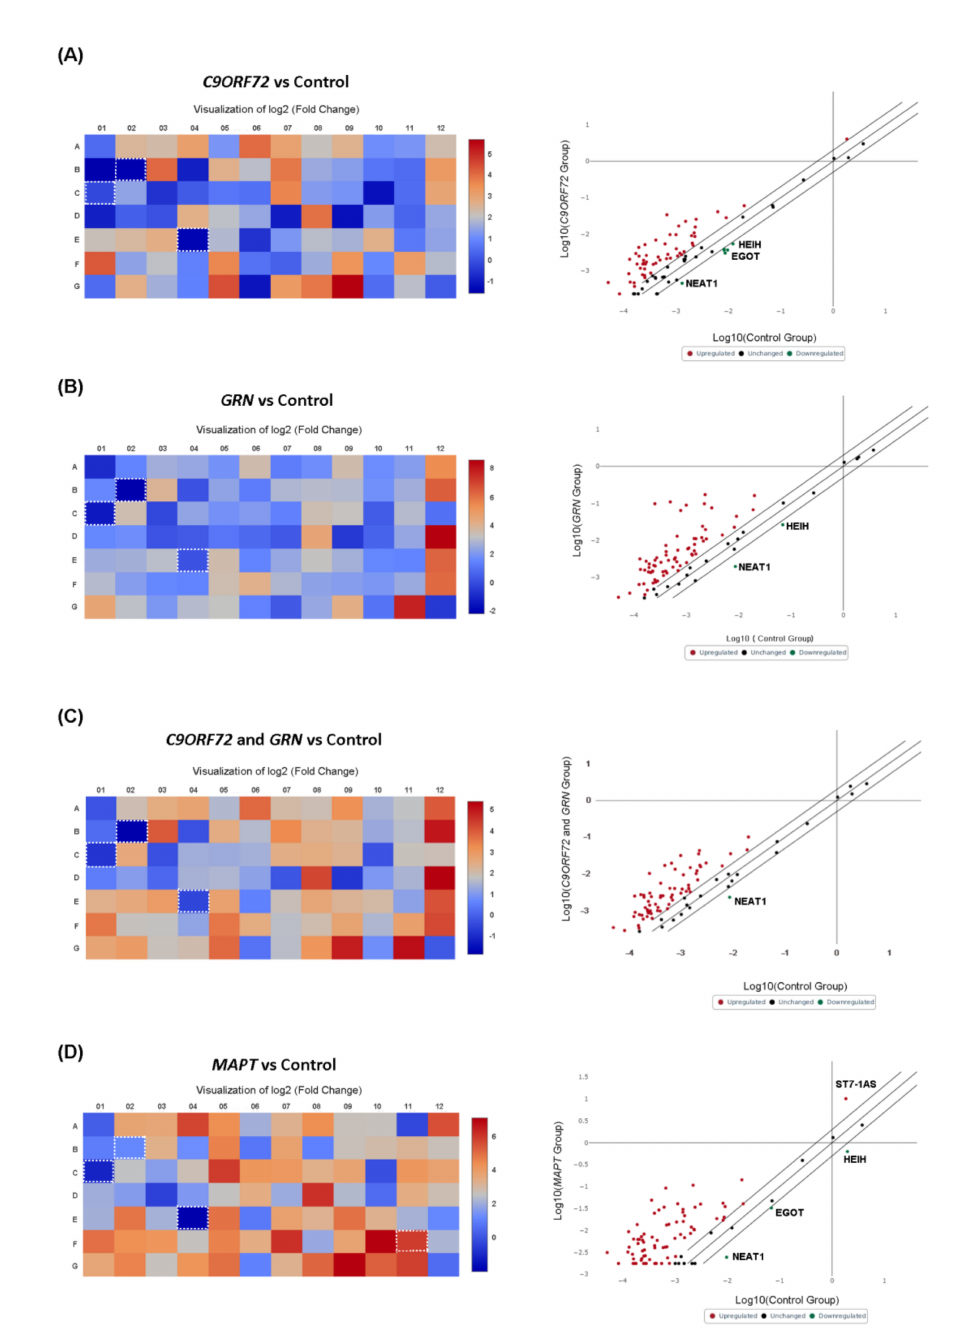
Figure 5. Heat Map of the expression fold changes for the 84 lncRNAs array in FTD C9ORF72 expansion carriers ( A ); GRN mutation carriers ( B ); GRN + C9ORF72 grouped mutation ( C ); MAPT mutation carriers ( D ); versus controls. Data are expressed as fold change (fold difference). Blue indicates downregulation, red upregulation. Each scatter plot compares the normalized expression of every gene on the PCR Array between the two selected groups by plotting them against one another to quickly visualize large gene expression changes. The center diagonal line indicates unchanged gene expression, while the outer diagonal lines indicate the selected fold regulation threshold. Genes with data points beyond the outer lines in the upper left and lower right corners are upregulated or downregulated, respectively, by more than the fold regulation threshold in the y-axis Group relative to the x-axis